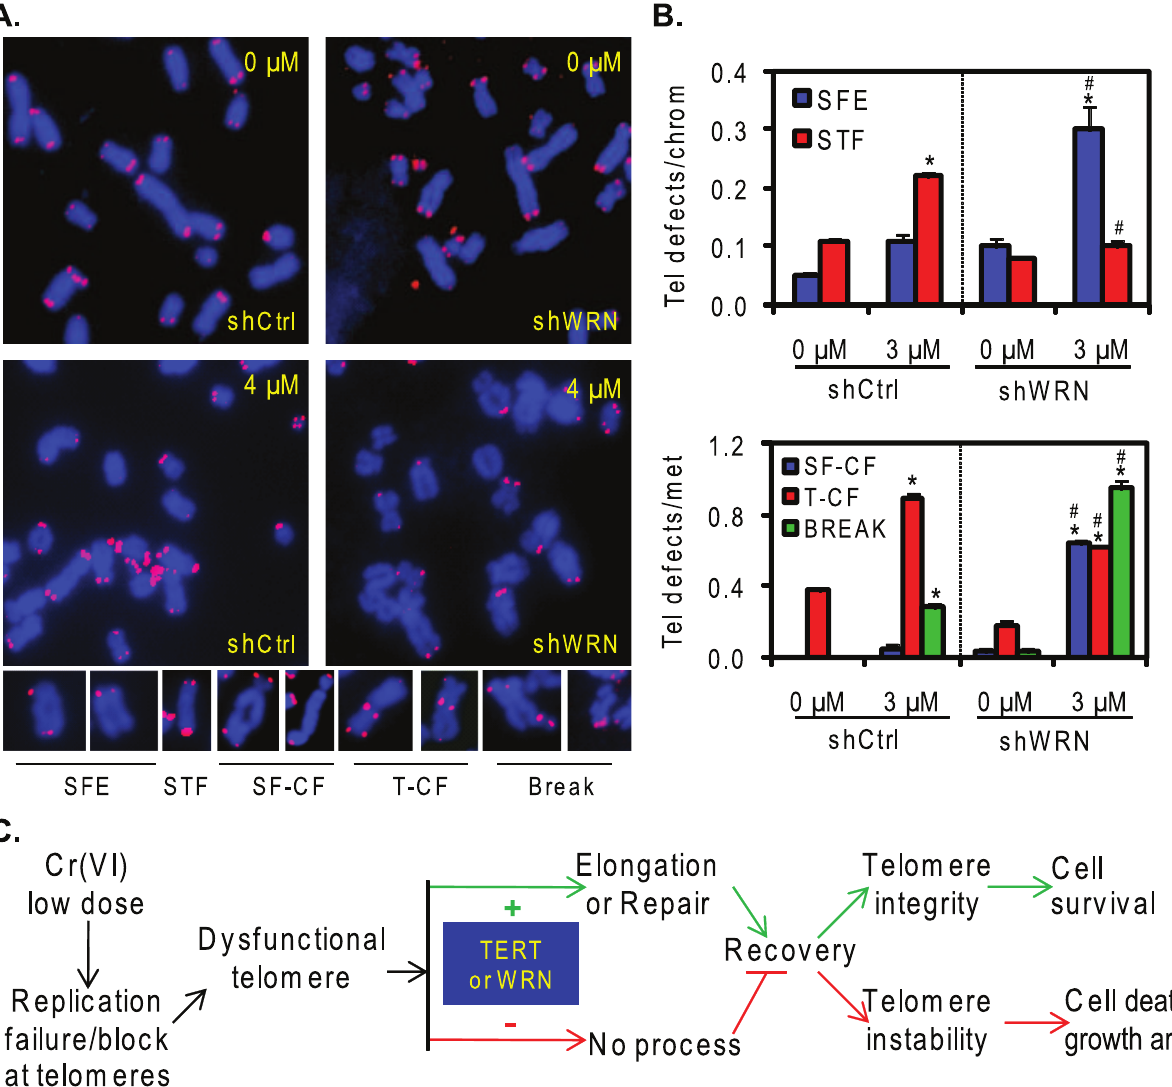
Figure 6. WRN protects against Cr(VI) induced telomere loss. (A) Representative telomere FISH of partial metaphases and telomere defects from shCtrl and shWRN cells exposed to 0 and 3 m M Cr(VI) for 48 h and cultured in Cr(VI)-free medium for 10 h. (B) Cr(VI)-induced telomere instability. Approximately 40 metaphases from two independent experiments were analyzed to quantitate Cr(VI)-induced telomere defects. Bars with a symbol of * indicates a significant difference between 0 and 3 m M in the same cell line and bars with a symbol of # indicates significant difference between exposed shCtrl and shWRN cells (p , 0.05). Telomere signal free ends, SFE; telomere sister chromatid fusions, SFT; chromosome/chromatid fusions lacking a telomere signal, SF-CF; chromosome/chromatid fusion with telomere signal at the fusion, T-CF; break indicates chromatid break. (C) Model for roles of WRN and telomerase in protection against Cr(VI)-induced telomere damage.